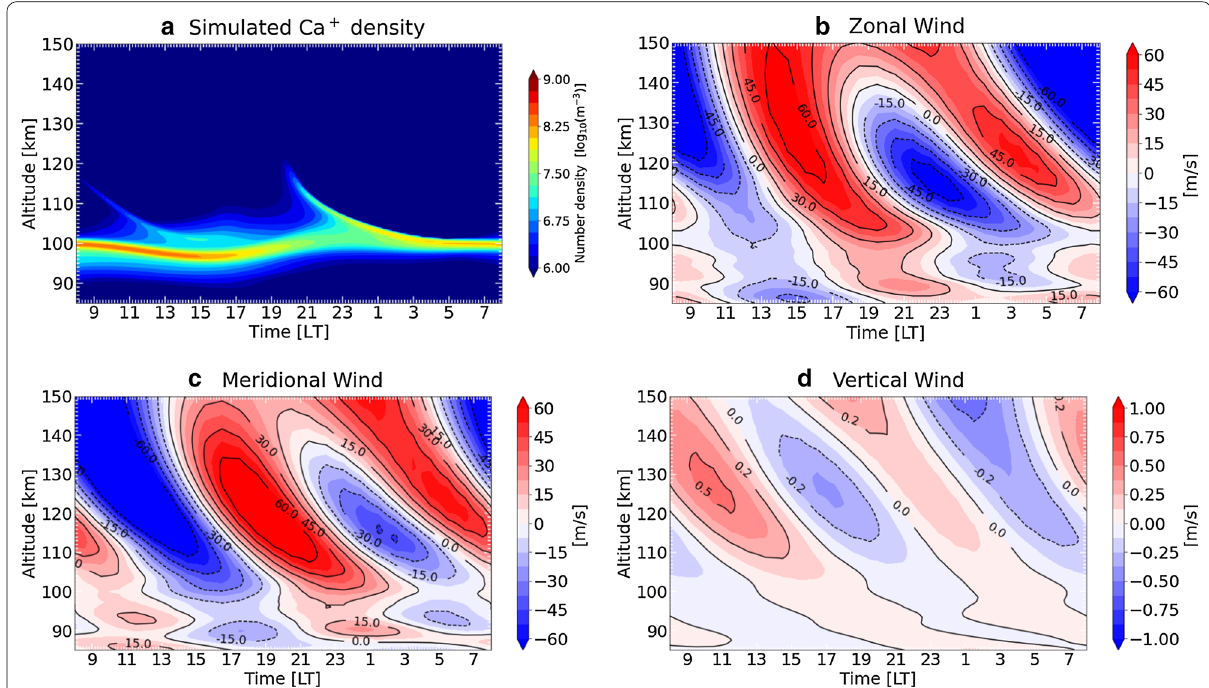
Fig. 1 Temporal variations of ( a ) simulated Ca + density and ( b ) zonal ( c ) meridional and ( d ) vertical component of neutral winds used as an input. Positive values in Fig. 1b–d represent eastward, southward and upward, respectively. “Layer 1” occurs at daytime and “Layer 2” occurs at